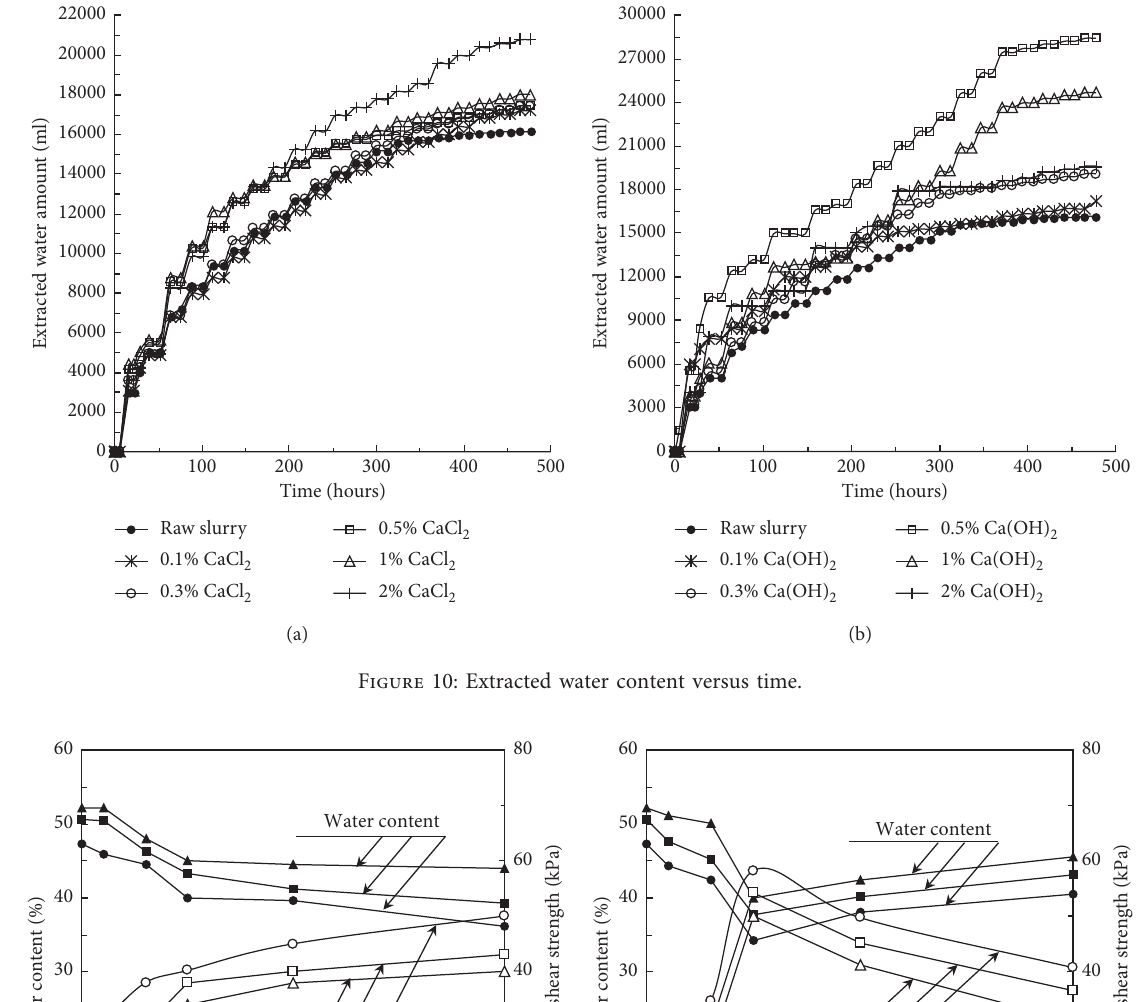
Figure 10: Extracted water content versus time.